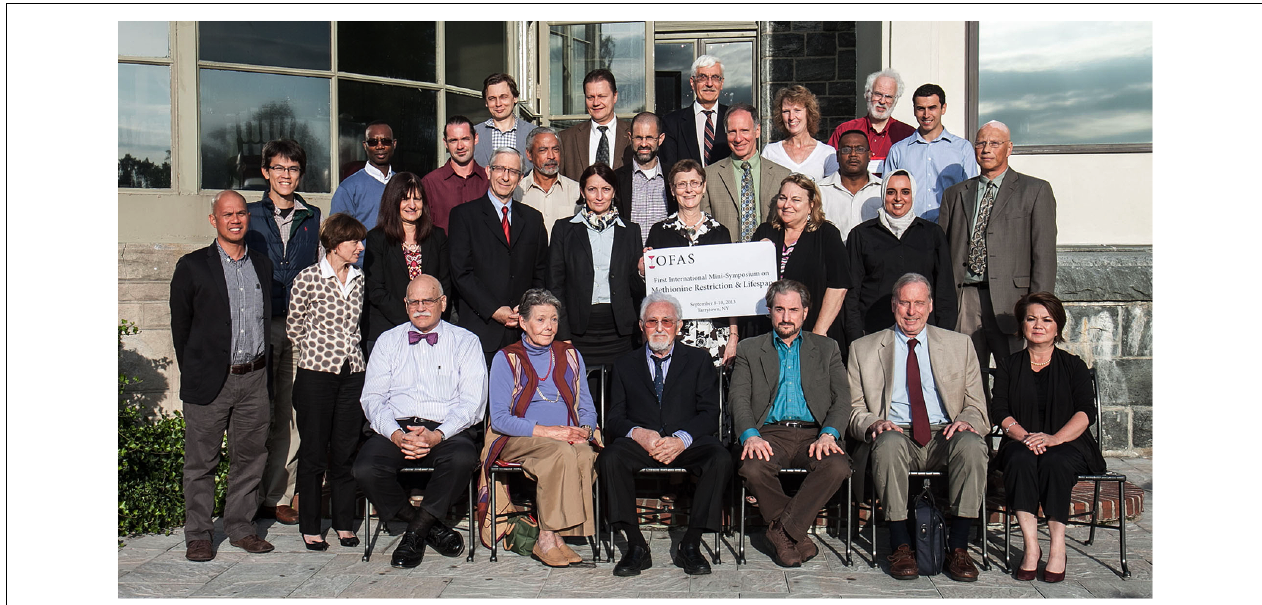
FIGURE 3 |Assembled participants of the First International Mini-Symposium on Methionine Restriction and Lifespan (Tarrytown, NY, USA, September 8–10, 2013). Sitting in the front row (L–R): Jay Zimmerman (Moderator), Nancy P. Durr, Norman Orentreich, David